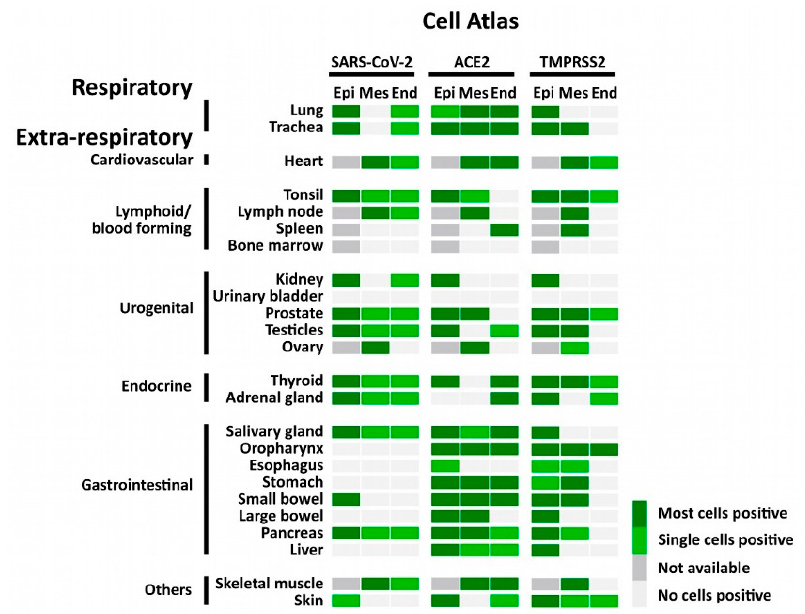
Figure 3. Atlas of cells that were positive for SARS-CoV-2, ACE2, and TMPRSS2 using FISH. The heatmap shows the pattern of SARS-CoV-2, expression of ACE2 and TMPRSS2 in different tissues. Epi = epithelial cells; Mes = mesenchymal stromal cells; End = endothelial cells; not available = tissue does not contain cell type.